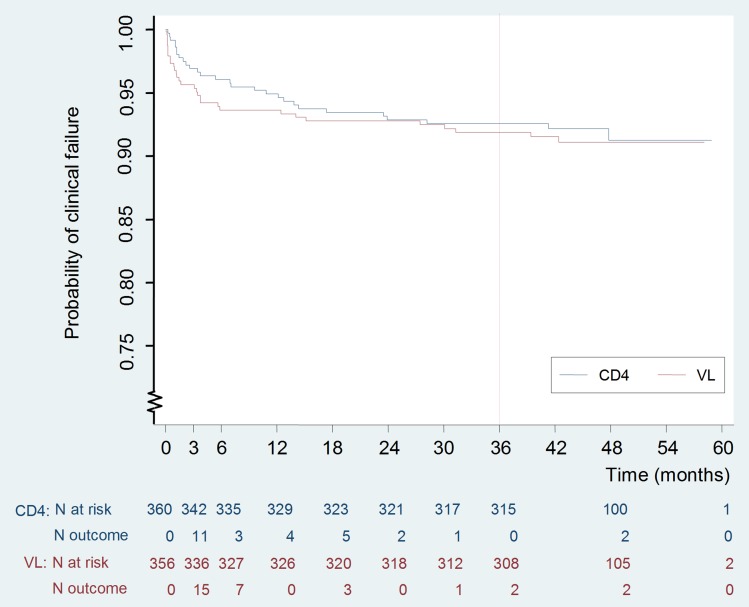
Kaplan Meier curve of occurrence of clinical failure.